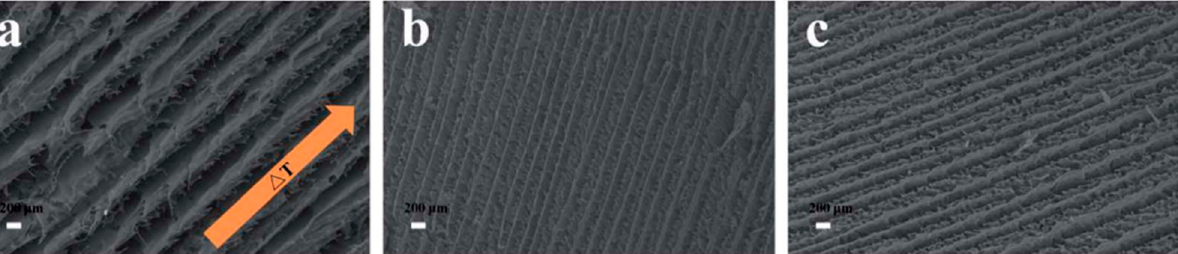
Figure 20. ( a – c ) Using the directionally frozen approach, SEM images of the longitudinal side views of freeze-casted porous foams were identified on the long axis. Reproduced from [121].